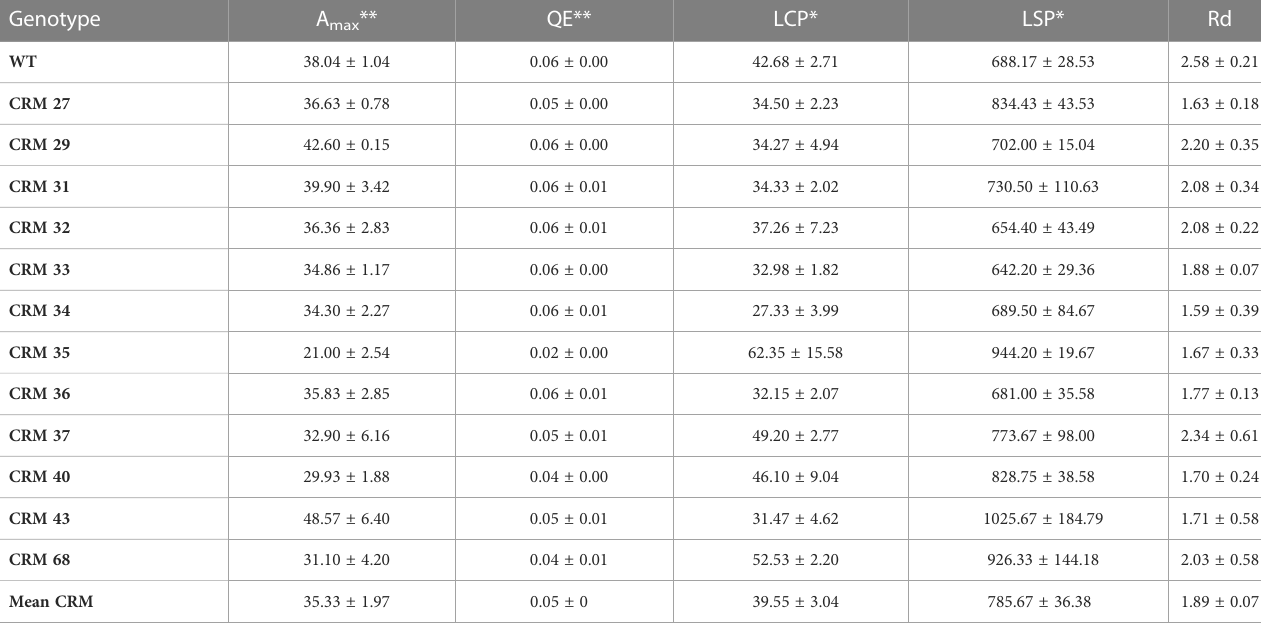
Meansandstandard errorofthemeansare shownwheren ≥ 3forA max ( m molm − 2 s − 1 ): maximum assimilationrate; QE(molmol − 1 ): quantumuseef fi ciency; LCP ( m molm − 2 s − 1 ): lightcompensation point; LSP ( m mol m − 2 s − 1 ): light saturation point and; Rd ( m mol m − 2 s − 1 ): dark respiration. * and ** indicates signi fi cant differences between lines according to ANOVA at P < 0.01 and P < 0.001, respectively (p<0.05). Supplementary Table 3 shows letters indicating differences according to post-hoc Bonferroni